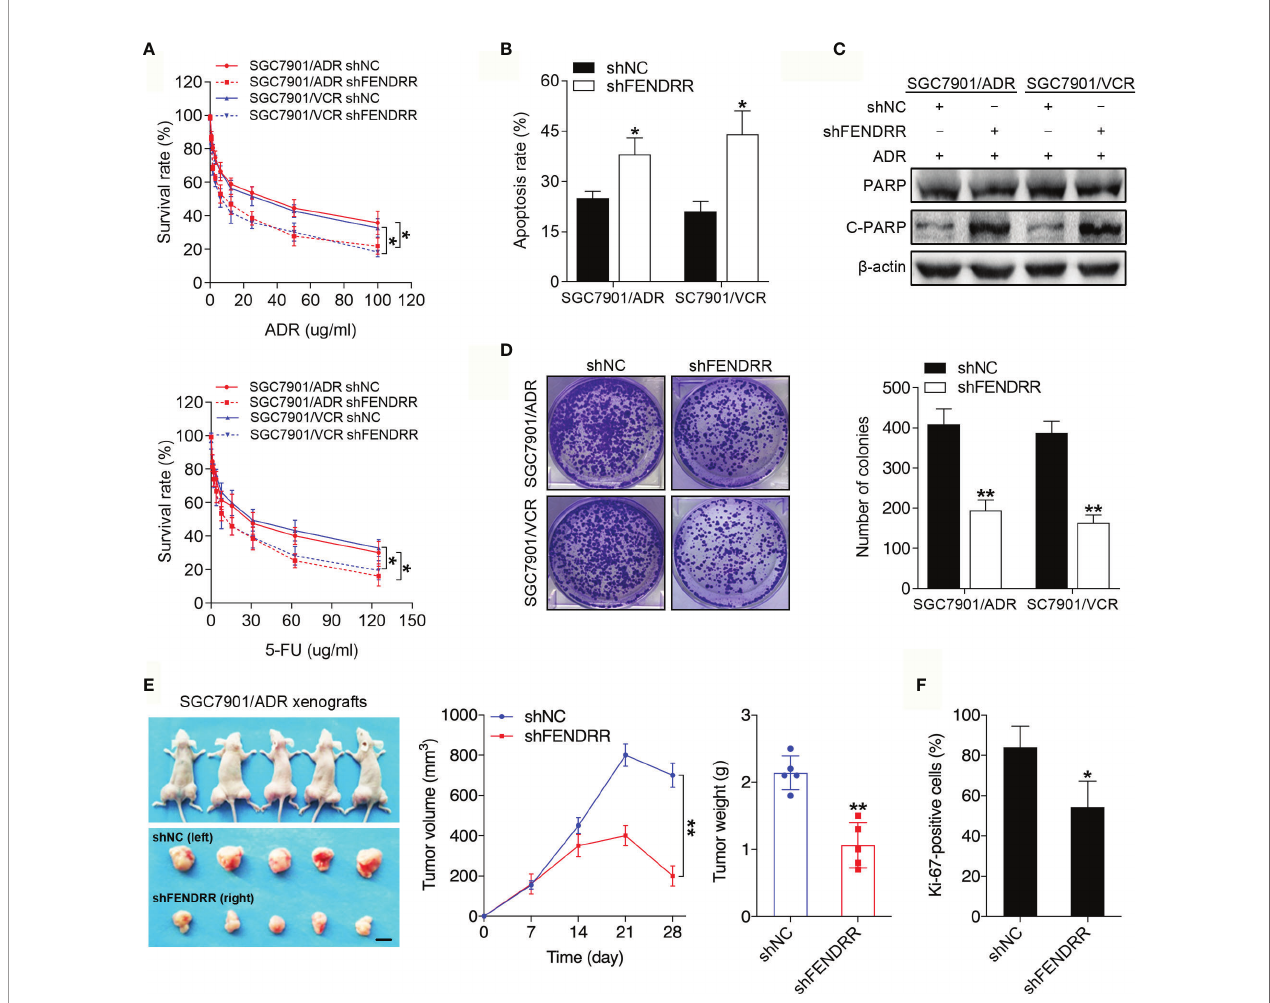
FIGURE 2 | FENDRR regulates the sensitivity of GC cells to chemotherapeutic agents in vitro and in vivo (A) Survival of indicated cells after step-up concentration of ADR and 5-FU treatment for 72 h was evaluated using the CCK-8 assay. (B) Apoptotic rate of the indicated cells treated with 5-FU. (C) Western blot analysis of PARP and C-PARP expression in the indicated cells treated with ADR. (D) Colony formation assay with the indicated cells treated with ADR. (E) LV-shFENDRR- infected cells were transplanted into the right fl ank of nude mice, and the corresponding control cells were transplanted into the left side. Left, representative images of tumors formed in nude mice (n=5) after ADR treatment are shown, scale bar, 1 cm. Middle, the tumor volumes of different groups were measured at the indicated time points. Right, the tumor weights of different groups measured after tumor isolation. (F) Quanti fi cation of the Ki67-positive staining of cells in xenografts from nude mice. ** P < 0.01, * P < 0.05, data are representative of three independent experiments, error bars,